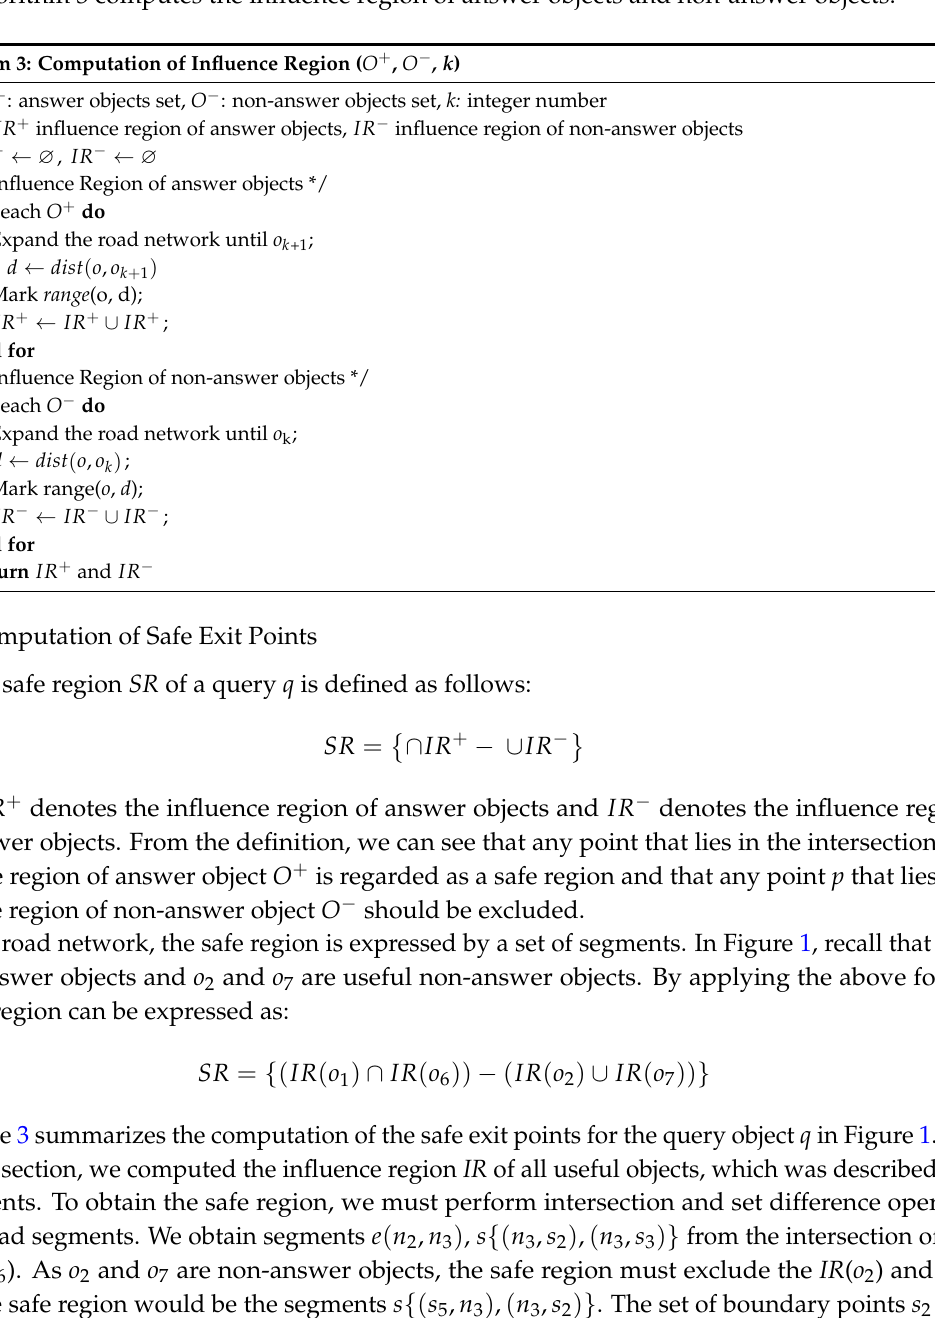
Algorithm 3 computes the influence region of answer objects and non-answer objects. Algorithm 3: Computation of Influence Region ( O + , O − , k )